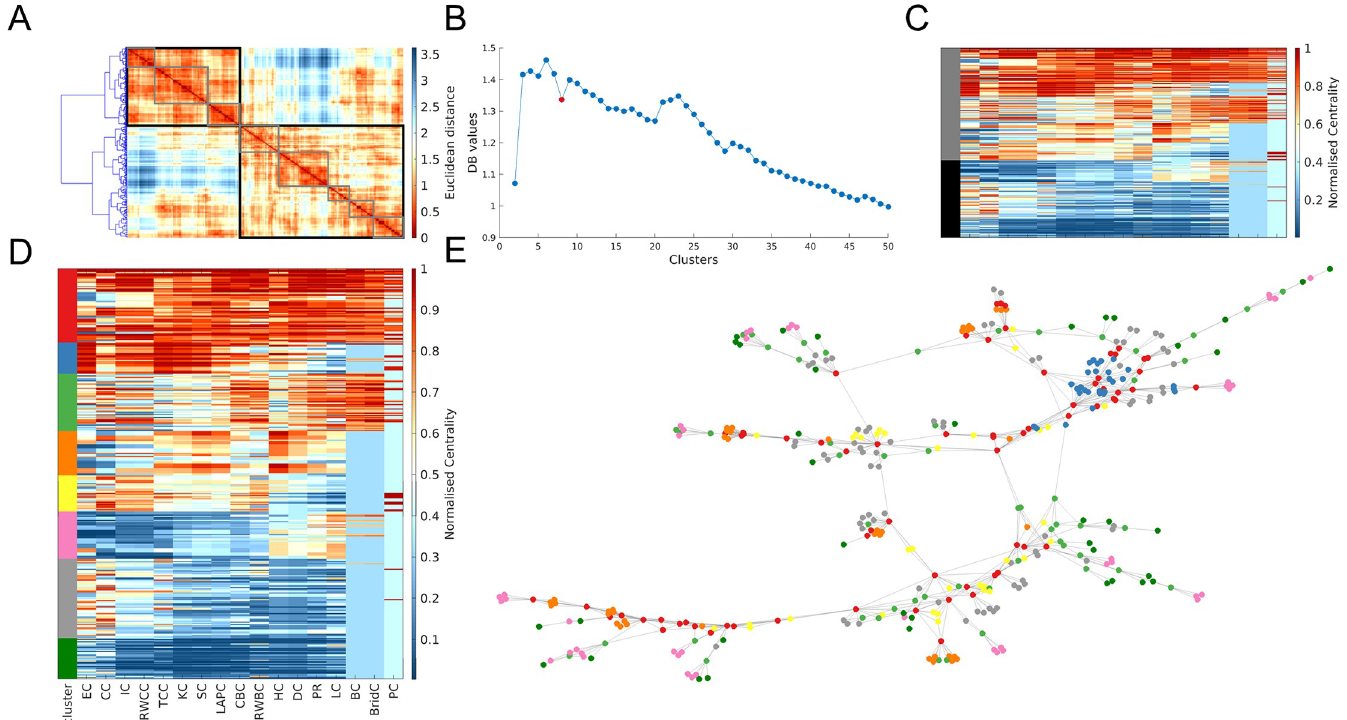
Fig 7. Multivariate centrality profiling of the network science author collaboration network. Panel A shows the dendrogram projected alongside the distance matrix of node pairs (ranks scores were normalised to be in the range 0–1 with 1 indicating the highest rank). The black and grey boxes and indicate the clusters when a two- cluster and eight-cluster solution is used, respectively. Panel B displays the results for the Davies-Bouldin (DB) criterion. A lower DB value represents a better clustering solution. The solution shown in panels D and E is labelled in red. Only the first 50 clustering solutions are shown for ease of visibility. Panel C shows the matrix of nodal centrality scores (each row is a node and each column is a measure) and how these are clustered in a two-cluster solution (the black and grey represent the two different clusters). Panel D shows the matrix of nodal centrality scores as well as the clusters each node was assigned to. Panel E shows a topological representation of the network, produced using the force-directed layout algorithm, where each node is coloured according to the cluster it was allocated to in panel D .